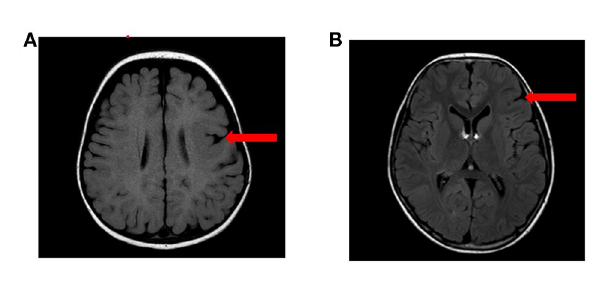
FIGURE1 The MRI results of the patients. (A) MRI results of case 3: left frontal MCD. (B) MRI results of case 10: left frontal